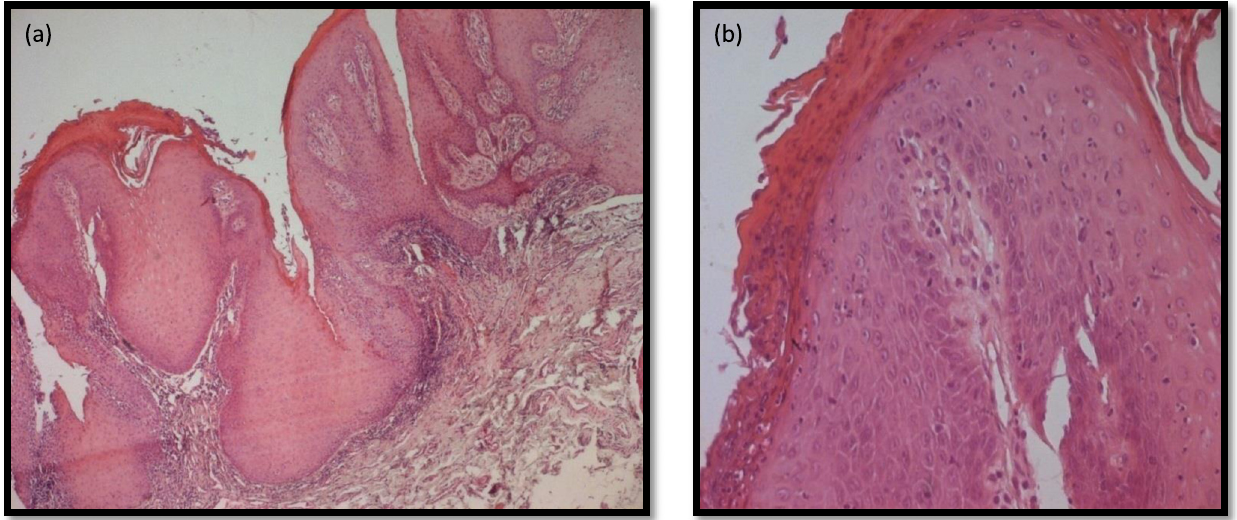
Fig. 2. (a) HE (cid:1) 200: Hyperplasia of the rete ridges and thinning of dermal papillae; Oedematous derm with dense cell in fi ltrate. (b) HE (cid:1) 400: Micro-abscesses of Munro (clusters of neutrophil polynuclear) within an hyperplastic and parakeratotic epithelial